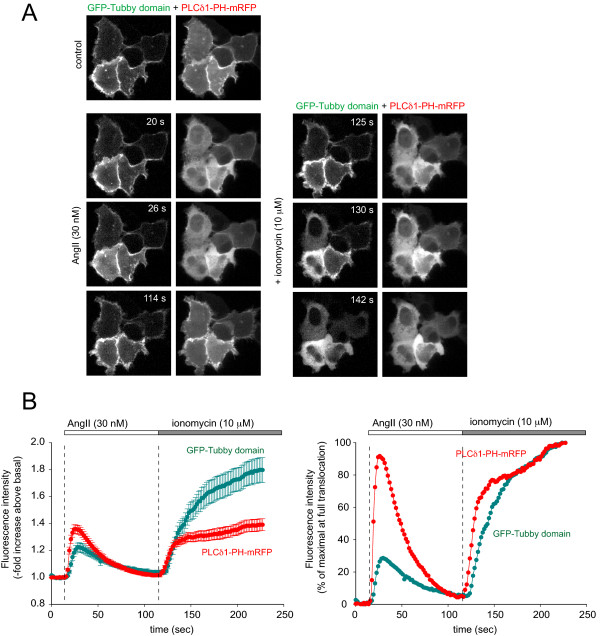
Translocation responses of Tubby-domain and PLCδ1PH domain in AngII and ionomycin stimulated HEK293-AT1 cells. HEK293-AT1 cells were co-transfected with the GFP-Tubby-domain and the PLCδ1PH-mRFP constructs. After 24 h, cells were analyzed by confocal microscopy. Cells were stimulated with 30 nM AngII (at 16 s) followed by 10 μM ionomycin (at 117 s) as indicated. Panel A shows a representative image series recorded at the indicated time points. Panel B shows the average responses (cytoplasmic fluorescence increase) of 50-54 cells (mean ± S.E.M) (left) and the average curve normalized to the maximal cytoplasmic fluorescence attained after ionomycin treatment (full translocation) (Panel B, right). Note the significantly slower and only partial response of the Tubby domain after AngII stimulation.